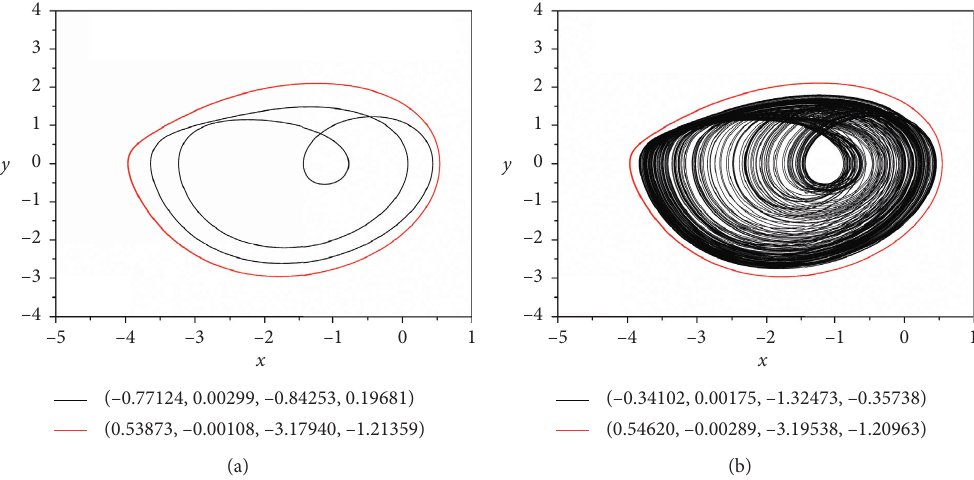
Figure 6: Coexisting attractors for (a) c � 1.897 and (b) c � 1.9, with a � 1.4, b � 0.3, and d � 0.9 and different initial conditions of system